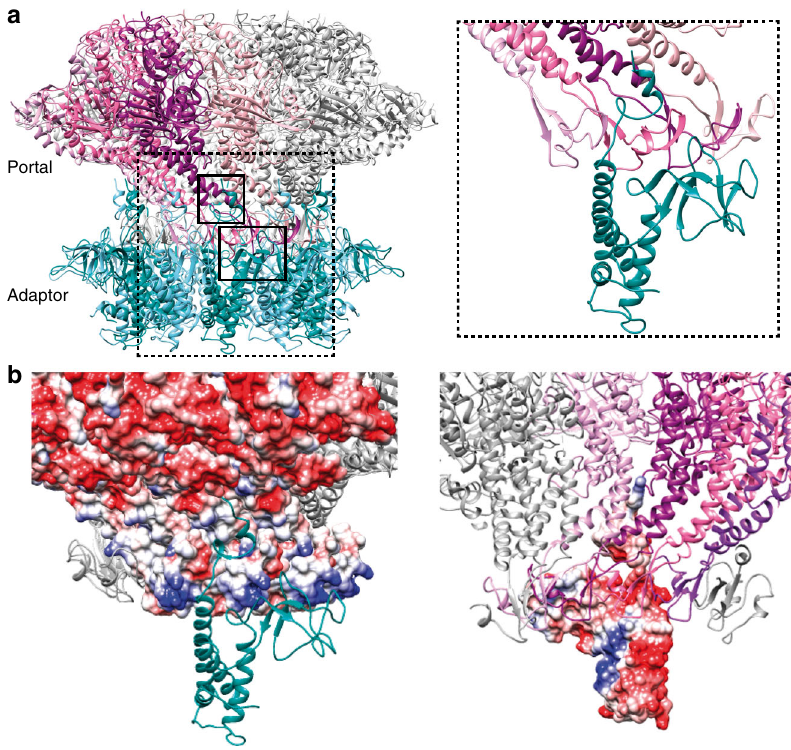
Fig. 4 Tail portal-adaptor interaction. a Ribbon representation of the gp8 portal and gp11 adaptor proteins in the tail complex. Left, binary gp8-gp11 complex; right, close-up of the interaction region. In order to facilitate the interpretation of the image, only one subunit of the gp11 oligomer is shown in the close-up view. The adaptor subunits are shown in dark green and light blue; the four subunits of gp8 interacting with gp11 subunit highlighted in the right panel are shown in plum, magenta, purple, and pink, whereas the rest of the subunits are indicated in grey. b Surface charge distribution of the portal/adaptor interaction. In order to facilitate the interpretation, a single monomer of gp11 protein is shown. Left, view from the outside the complex showing the portal electrostatic surface and a ribbon representation of gp11. Right, view from the inside of the channel, showing the adaptor electrostatic surface, and a ribbon representation of the portal